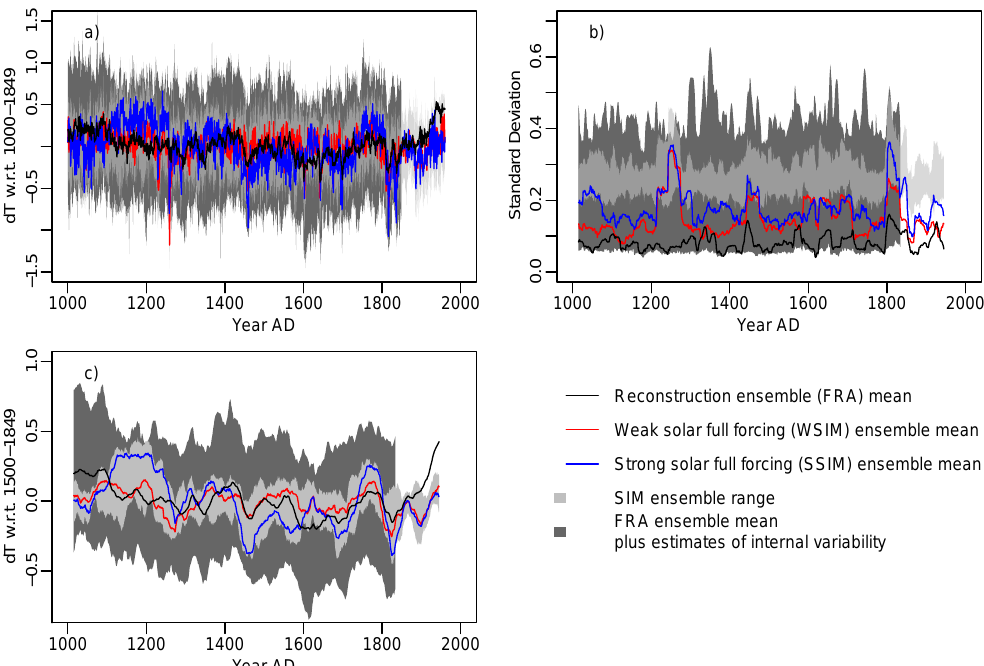
Fig. 2. (a) Time series, (b) moving 31yr standard deviations and (c) moving 31yr means for the SIM Northern Hemisphere temperature data against the reconstructed target. Black is the verification data target and transparent light grey shading is the range of the SIM ensemble. Red (blue) lines are for the WSIM (SSIM) full-forcing simulation ensemble means. Dark grey shading is the range of the reconstruction ensemble-mean target with added internal variability estimates. Here and in Fig. 3, the data including the estimate for internal variability is only shown for the period of analysis from the start of the millennium to the mid-19th